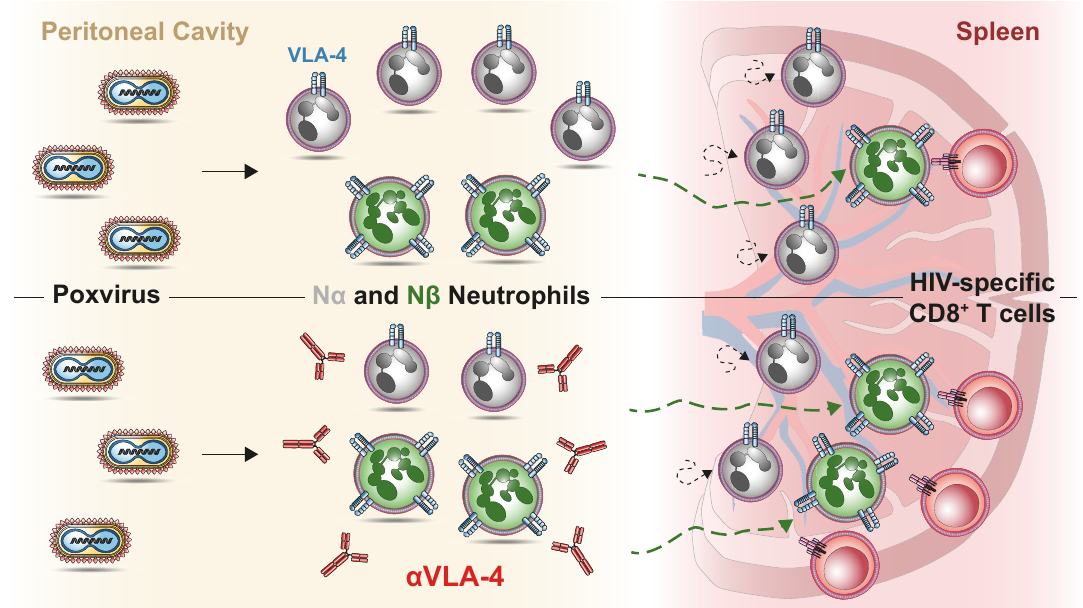
Fig. 7 Model of action. After poxvirus infection in the peritoneal cavity, two distinct subtypes of neutrophil (N α and N β ) are generated. N β are characterized by overexpression of the trans-endothelial migration marker VLA-4 and an increased ability to interact with antigen-speci fi c CD8 + T cells in the spleen (top panel). Poxvirus infection in combination with VLA-4 inhibition increases N β /N α ratio in peritoneal cavity and spleen leading to augmented HIV-speci fi c CD8 T-cell responses (bottom